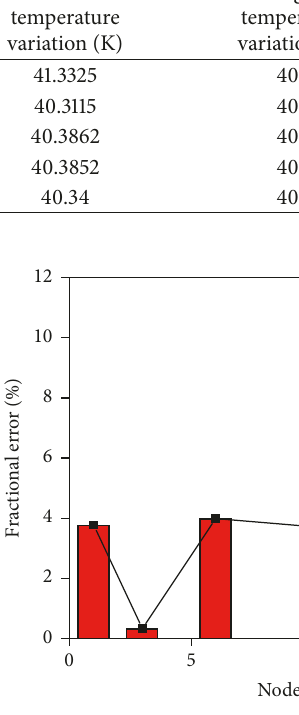
Figure 10: The influence of pressurizer node number on the fractional error between calculated and designed reactor pressure